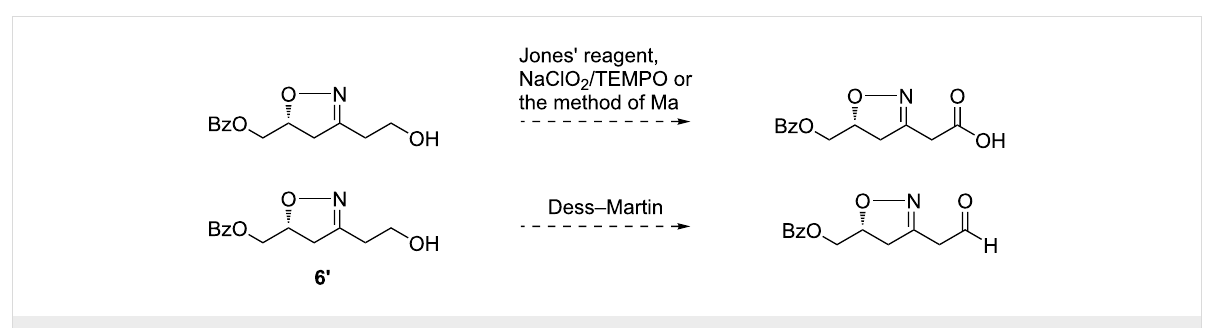
Scheme 4: Attempted oxidations of 6'